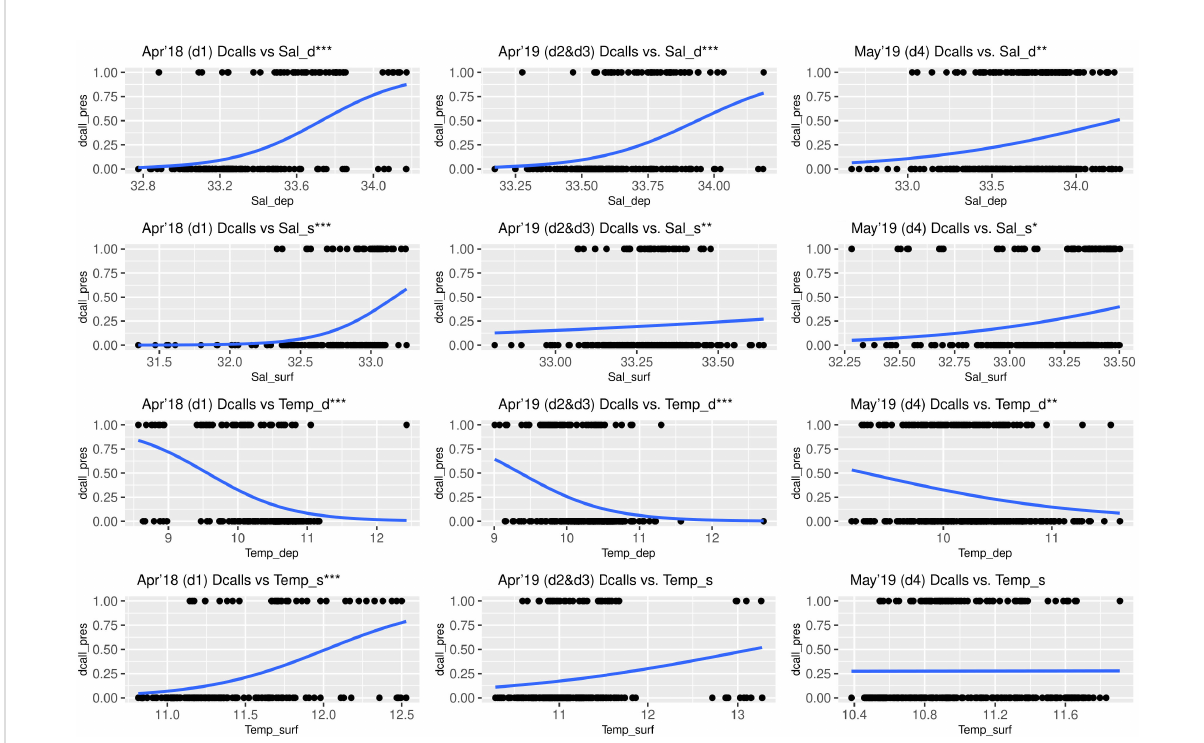
FIGURE 6 Generalized Linear Model response curves for probability of sei whale detection (downsweeps and upsweeps) and deep layer salinity (SalD), surface layer salinity (SalS), deep layer temperature (TempD) and surface layer temperature (TempS). Salinity in psu and temperature in °C. Study periods: April 2019 (deployment 1), April 2019 (deployments 2 and 3), May 2019 (deployment 4). Bonferroni adjusted signi fi cance codes: *0.00416 > p > 0.00083; **0.00083 > p > 0.000083; *** p <